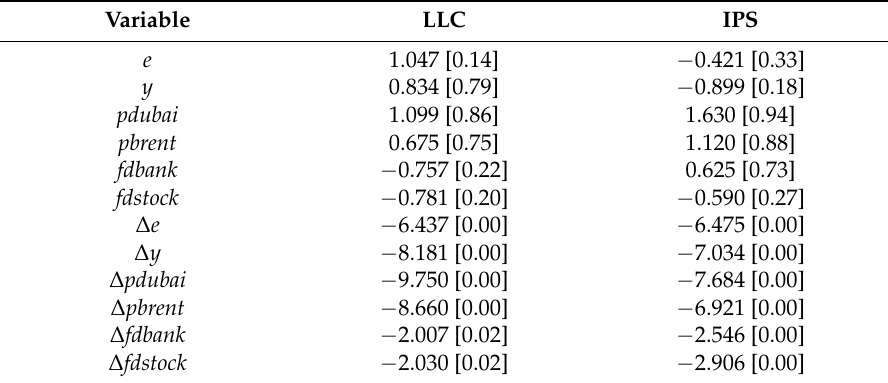
Table 4. Unit root results.